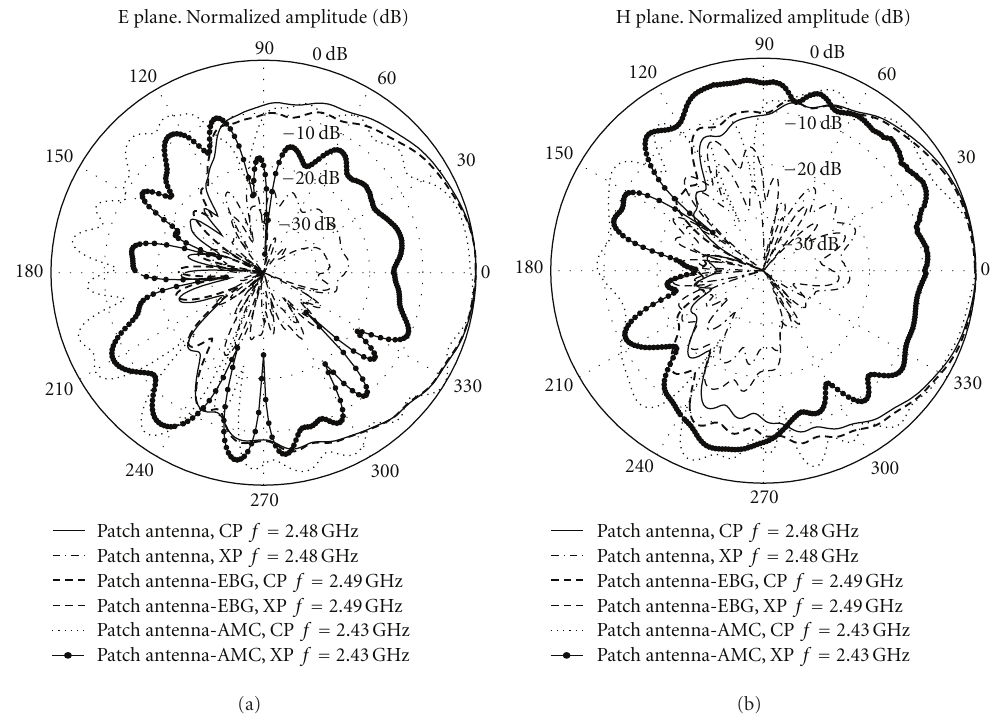
Figure 8: Measured radiation patterns of the prototypes: Patch antenna, patch antenna-EBG, and patch antenna-AMC. Table 1: Comparison between the three designs.